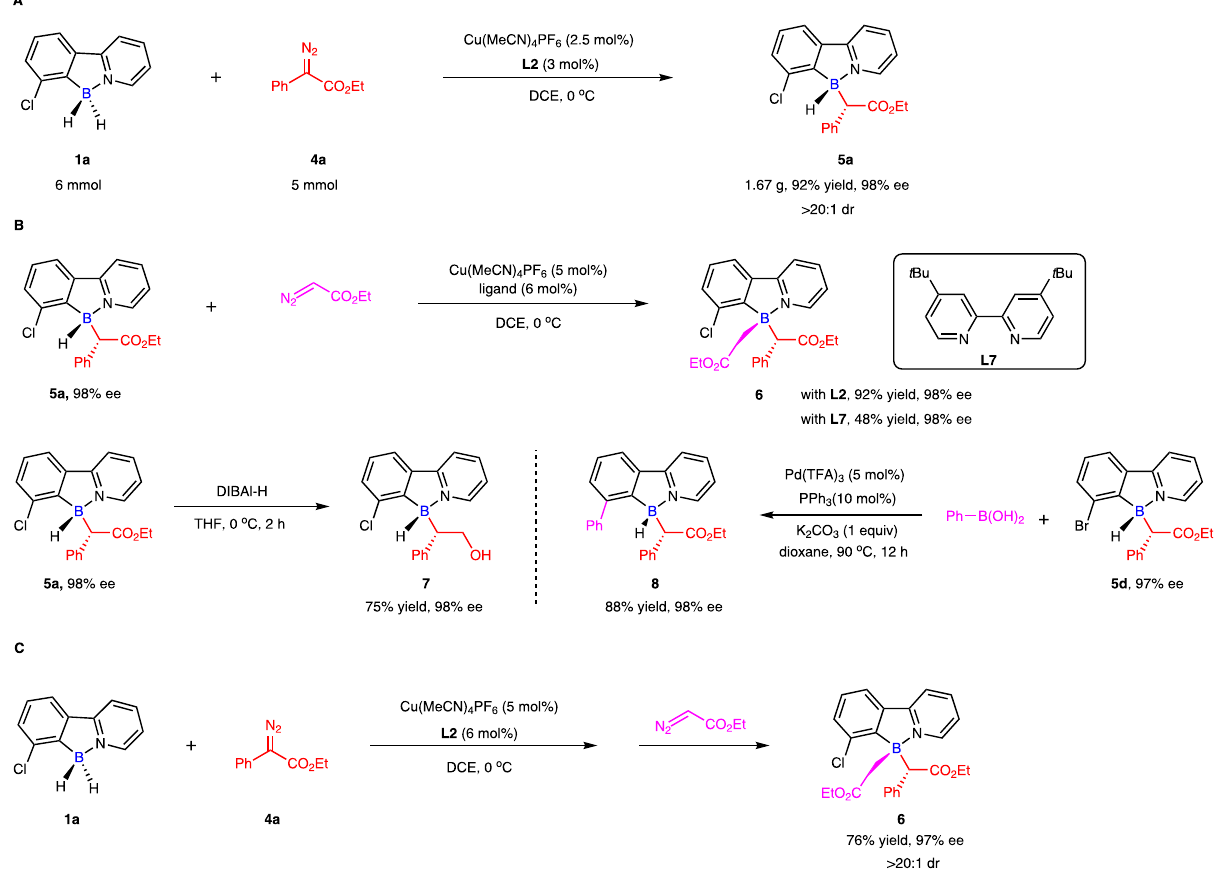
Fig. 8 Gram-scale reaction and transformations. A Gram-scale reaction. B Transformations. C One-pot reaction to access 3-carbon substituted boron- stereogenic compound 6 .